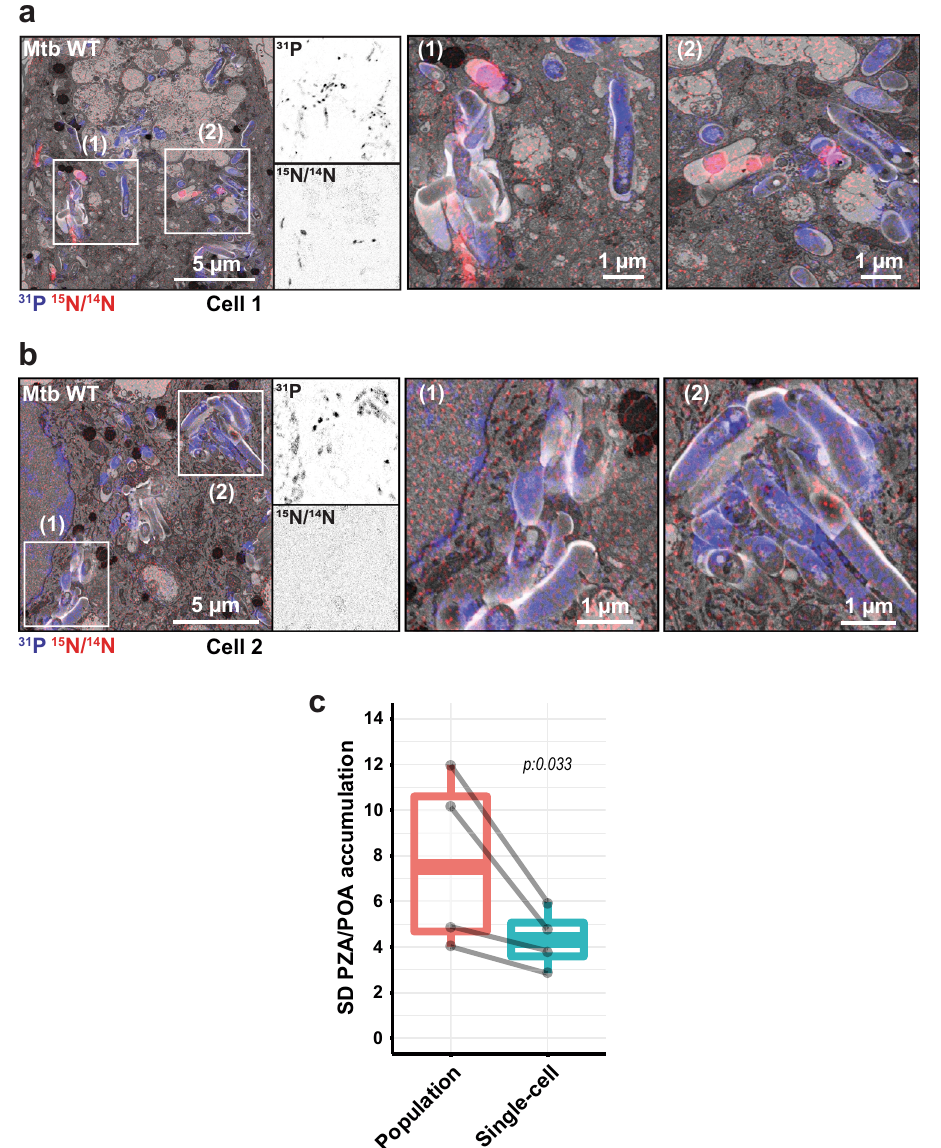
Fig. 1 Heterogeneous accumulation of PZA/POA within Mtb-infected MDM. a , b Mtb-infected MDM treated with 30 mg/L [ 15 N 2 , 13 C 2 ]-PZA for 24 h. EM micrograph is overlaid with 31 P (blue) and 15 N/ 14 N (red) NanoSIMS images. Magni fi cations show 31 P (top panel) and 15 N/ 14 N (bottom panel) individual signals at the single bacterial-cell level. Scale bar corresponds to 5 µ m. Regions of interest (1) and (2) highlighted by white rectangles, are shown in detail in the right panels respectively. Scale bar corresponds to 1 µ m. Micrographs are representative of four independent experiments. c Comparison of standard deviation (SD) in 15 N/ 14 N ratiometric signals between bacteria contained within the same macrophage (single-cell level) and across Mtb in all macrophages (population level). A total of 1649 intracellular bacteria were analysed from n = 4 biologically independent experiments. Results are shown as box-and-whisker plot where minima, maxima, median and percentile are displayed with the linked-results from individual experiments. Statistical signi fi cance was assessed by using a two-tailed t-statistic test from the linear model. Source data are provided as Source Data fi